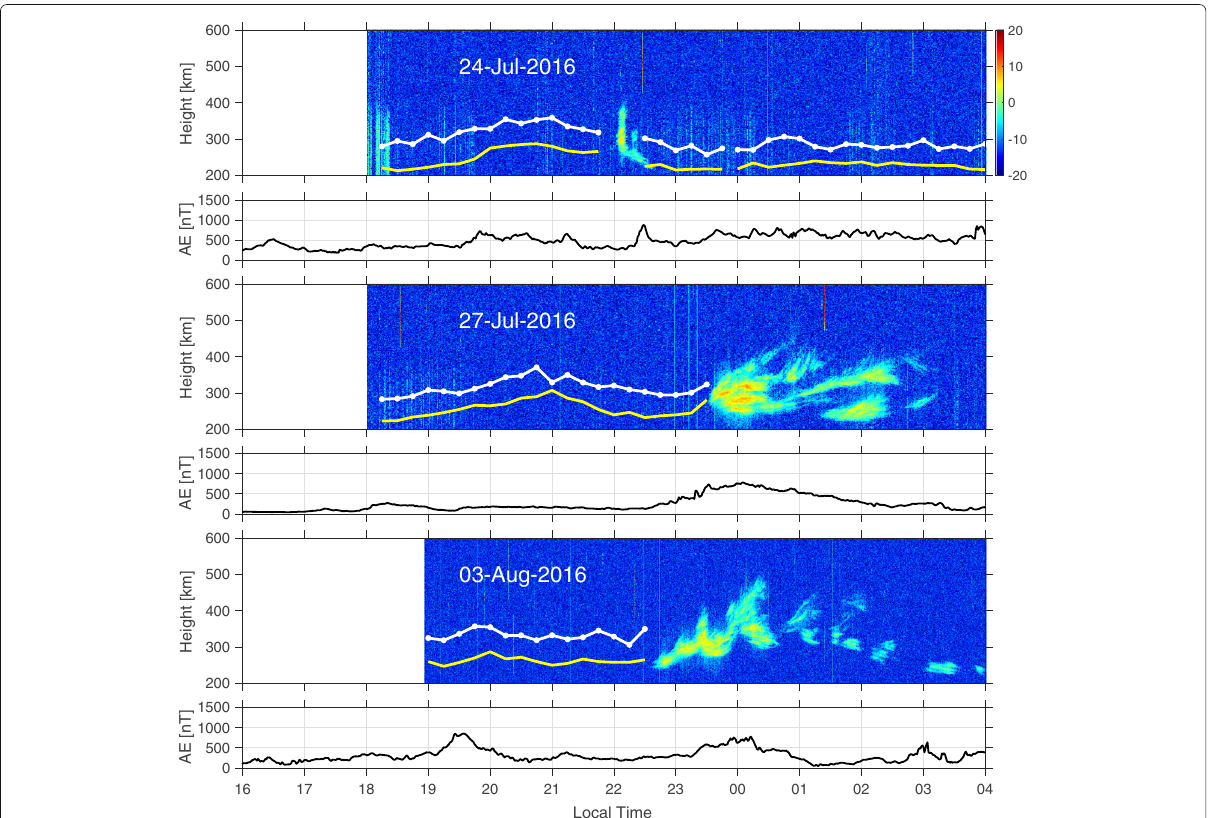
Fig. 2 RTI maps for July 24–25, July 27–28, and August 3–4, 2016. Digisonde estimates of hmF2 (white line with markers) and h’F (solid yellow line) are also shown. The auroral electrojet (AE) index is also shown, below each RTI